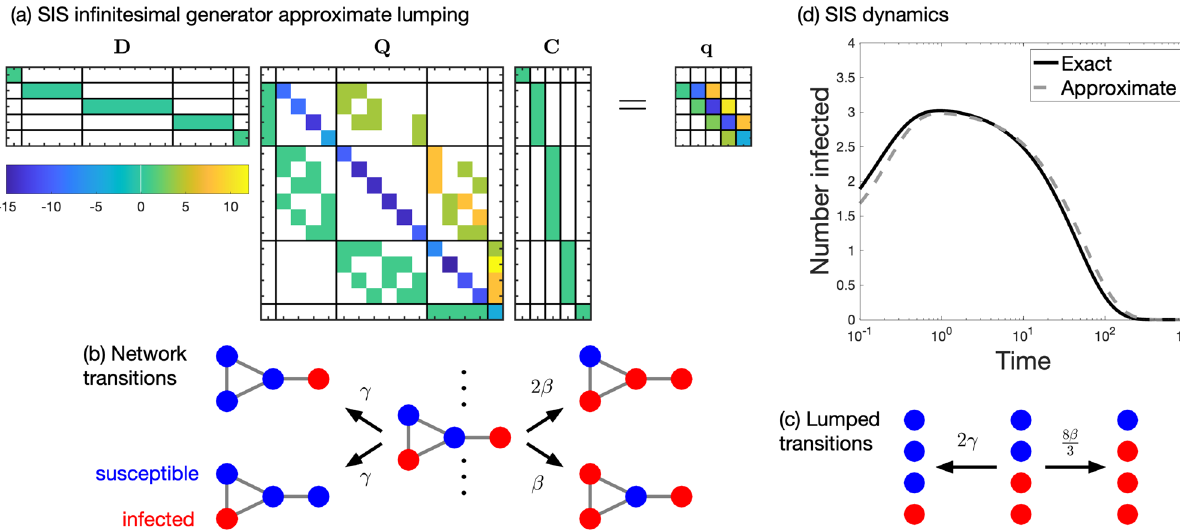
Fig. 1 Illustration of approximate lumping for a small four vertex ‘ coat hanger ’ network with SIS (susceptible – infected – susceptible) dynamics. a Illustrates the matrix multiplication DQC = q that lumps the in fi nitesimal generator Q of the full Markov chain using the collector and distributor matrices, C and D , respectively, to produce the tridiagonal approximate lumping in fi nitesimal generator q . Colour indicates the value of the corresponding matrix entry for the infection rate β = 4 and recovery rate γ = 1; zero entries are white. The horizontal and vertical lines indicate the different groupings of states by level; level 0 is in the left/top and level 4 is on the right/bottom. b Illustrates transitions from a state with two infected vertices that are accounted for by the full Markov chain. Blue vertices indicate susceptible and red vertices indicate infected. The transition rates are given next to the corresponding arrows. The vertical dots indicate that there are more states with two infected vertices. c Illustrates the corresponding transition rates for the approximate lumping from level two, i.e. two infected vertices. In general the lumped recovery rate is γ i and the lumped infection rate is β zi ( N − i )/( N − 1), where i is the level (number of infected individuals); for the case illustrated N = 4, z = 2 and i = 2. d Illustrates the average number of infected vertices from solutions to the master equation for the full Markov chain (exact) and the approximate lumping (approximate). Note the log scale on the horizontal time